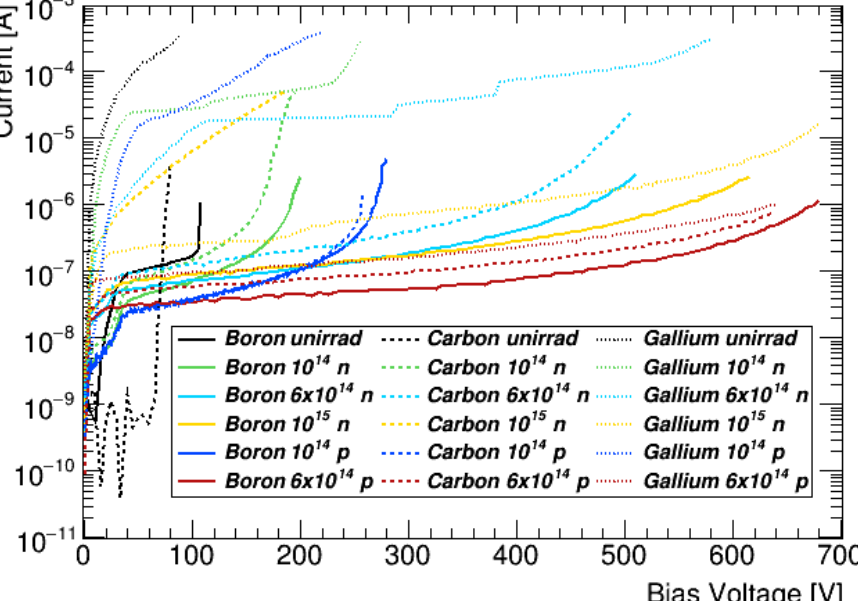
Figure 4. I-V characteristic curves (total = pad + guard ring) before and after three different irradiation levels at −